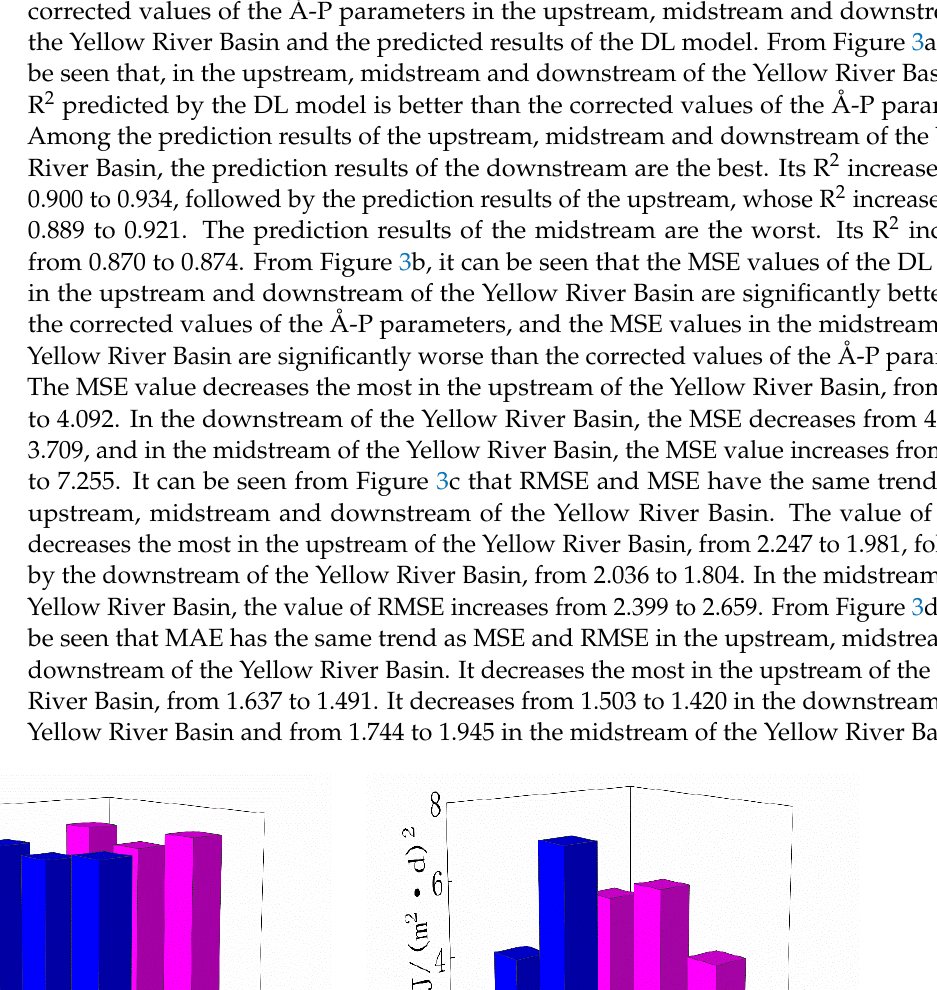
Figure 3. ( a ) The determination coefficient R 2 values of the prediction results of the corrected Å-P parameters and the DL model in the upstream, midstream and downstream of the Yellow River Basin; ( b ) The mean square error MSE values of the prediction results of the corrected Å-P parame- ters and the DL model in the upstream, midstream and downstream of the Yellow River Basin; ( c ) The rooted mean square error RMSE values of the prediction results of the corrected Å-P parameters and the DL model in the upstream, midstream and downstream of the Yellow River Basin; ( d ) The mean absolute error MAE values of the prediction results of the corrected Å-P parameters and the DL model in the upstream, midstream and downstream of the Yellow River Basin. In general, the evaluation metrics of the DL model are significantly better than the corrected values of the Å-P parameters in the upstream and downstream of the Yellow River Basin. Among them, the overall prediction results of the upstream are the best. R 2 increases from 0.889 to 0.921. MSE, RMSE and MAE are reduced by 22.11%, 11.84% and 8.94%, respectively, followed by the overall prediction effect of the downstream, whose R 2 increases from 0.900 to 0.934 and whose MSE, RMSE and MAE are reduced by 13.21%, 11.40% and 5.55%, respectively. Compared with the corrected values of the Å-P parame- ters, the overall prediction results in the midstream of the Yellow River Basin are poor. R 2